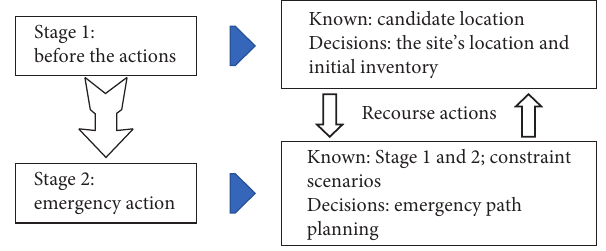
Figure 1: Schematic of the TS-SCC model. Table 1: Description of relevant